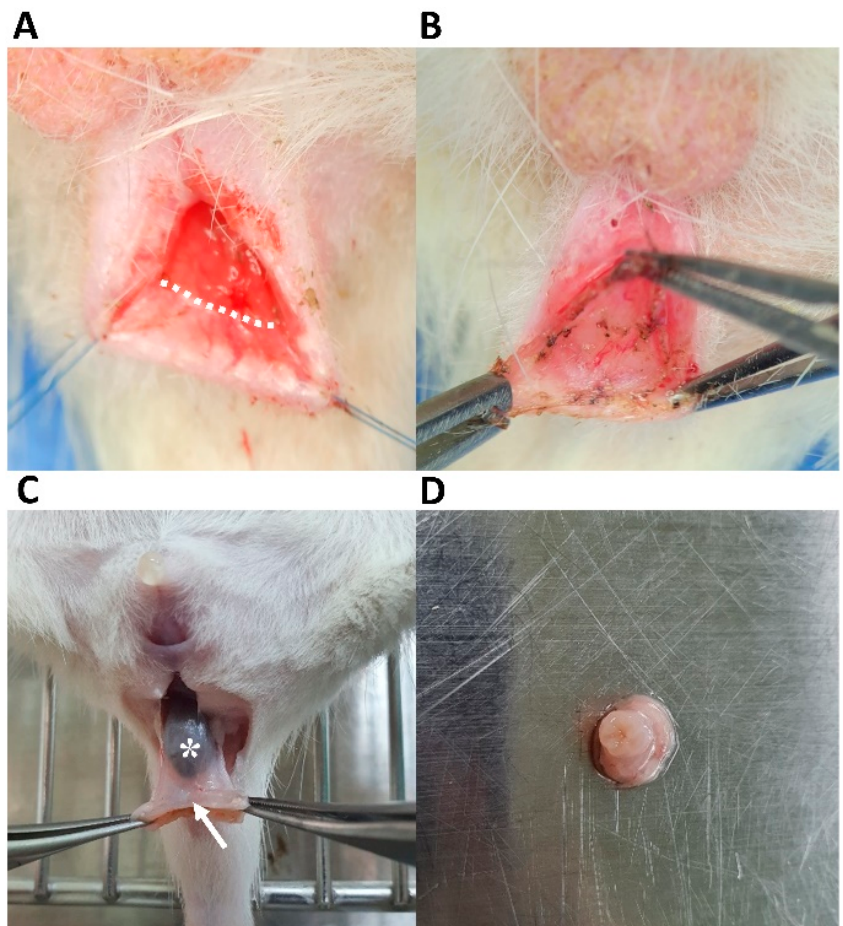
Figure 1. Development of an anal incontinence model targeting the internal anal sphincter. ( A ) A transverse incision (dotted line) was made at the posterior intersphincteric groove. ( B ) Intersphincteric dissection via the space between the submucosal and muscular layers. ( C ) The anal sphincter was harvested using caudal traction at the anoderm (arrow) from the distal rectum with feces *. ( D ) Anal sphincter specimen after removal of the anoderm.